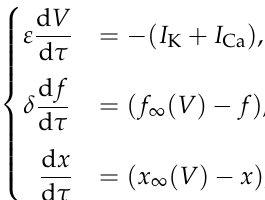
and G K used as bifurcation cm 2